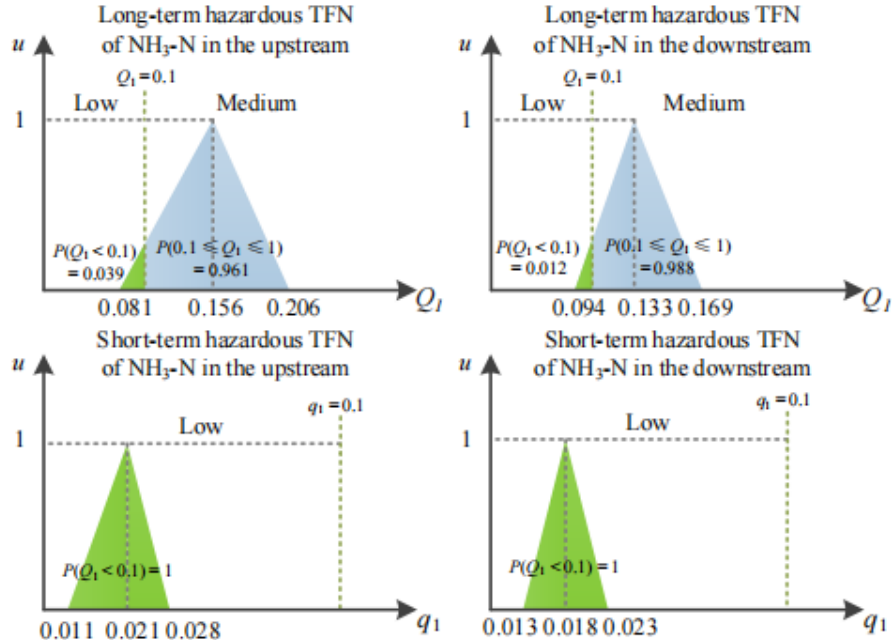
Figure 6. Hazardous TFNs of NH 3 -N before dam construction.